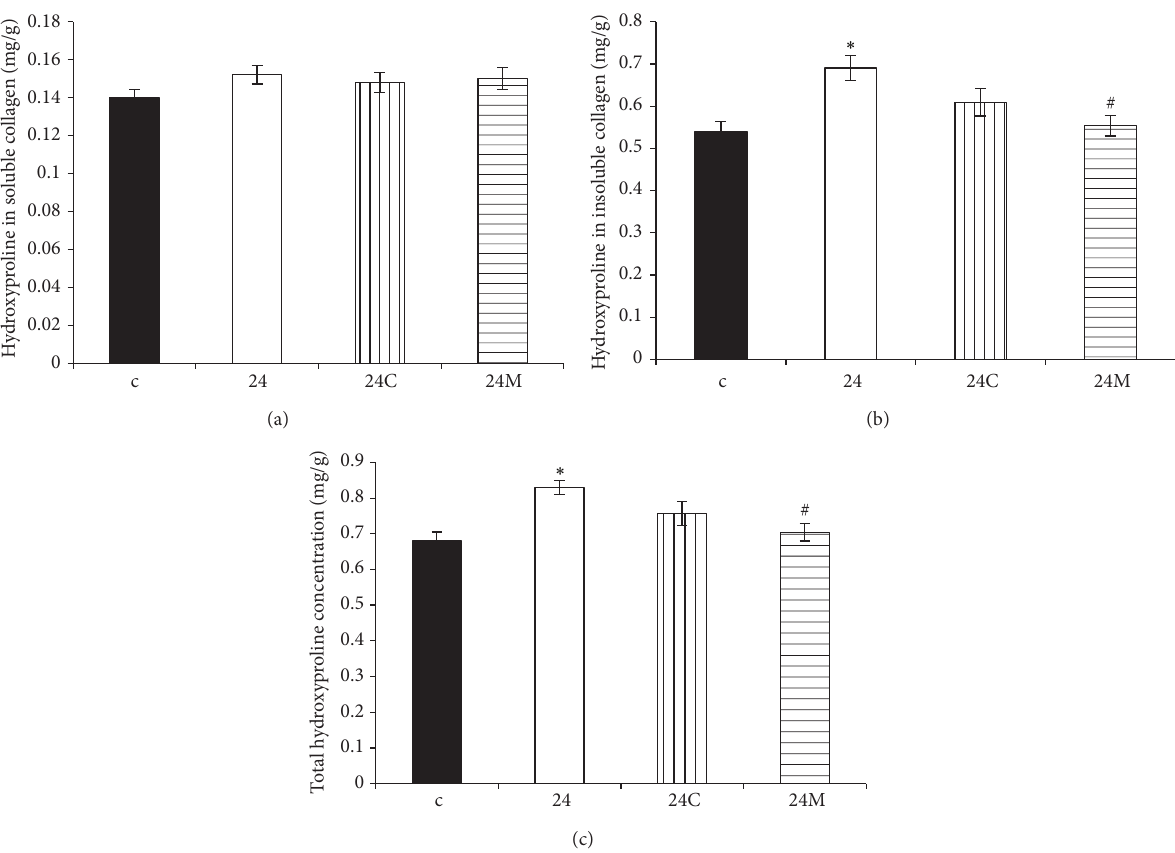
Figure 3: The influence of captopril (24C) and melatonin (24M) on hydroxyproline concentration in soluble (a) and insoluble (b) collagen proteins and on total hydroxyproline concentration (c) in 24 hours/day continuous light exposure-induced hypertension (24). c: Wistar controls. ∗ 𝑃 < 0.05 versus c; # 𝑃 < 0.05 versus 24. Table 1: The body weight (BW), right ventricle weight (RVW), relative RVW (RVW/BW), and left ventricle weight (LVW) in control rats (c), rats exposed to 24 h/day continuous light without treatment (24), and rats treated with captopril (24C) and melatonin (24M).